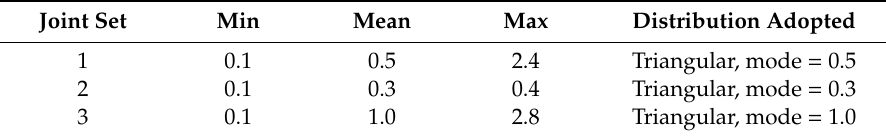
Table 3. Range of spacing values for joint sets J1 through